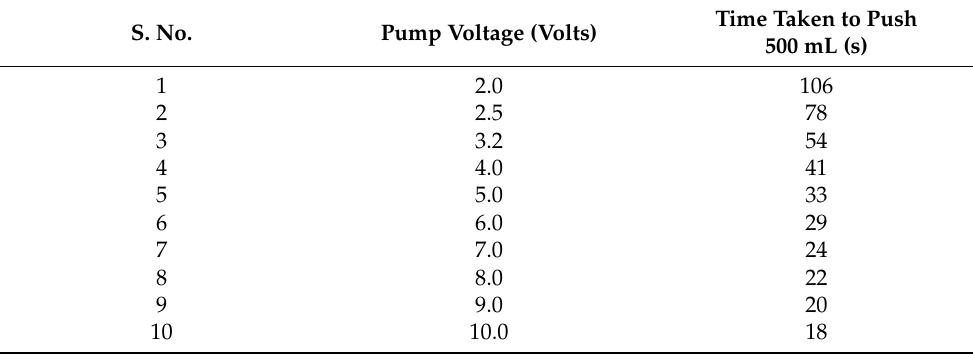
Table 1. Pump voltage vs. time taken to fill 500 mL.